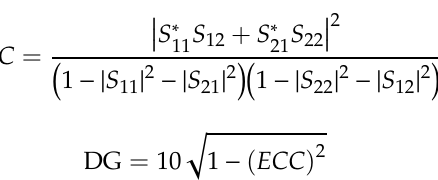
Figure 9. ECC and diversity gain of proposed antenna. Figure 8. Measured and simulated radiation patterns ( a ) 3.3 GHz; ( b ) 5.5 GHz; and ( c ) 8 GHz.